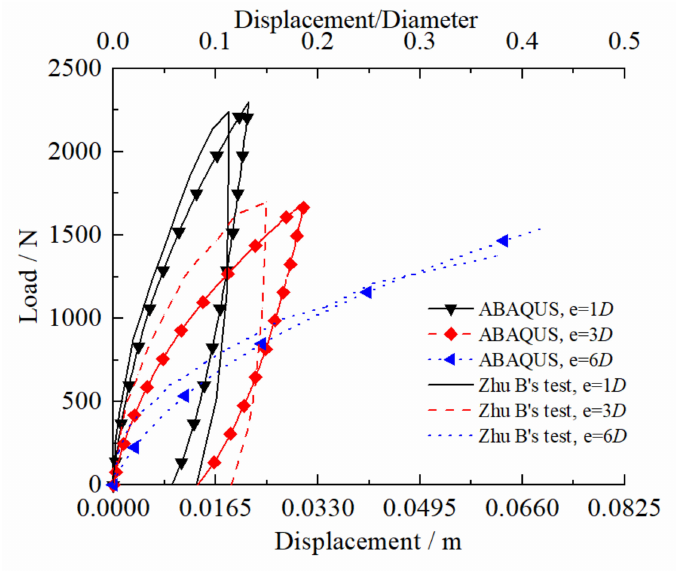
Figure 4. Load–displacement curves at the loading